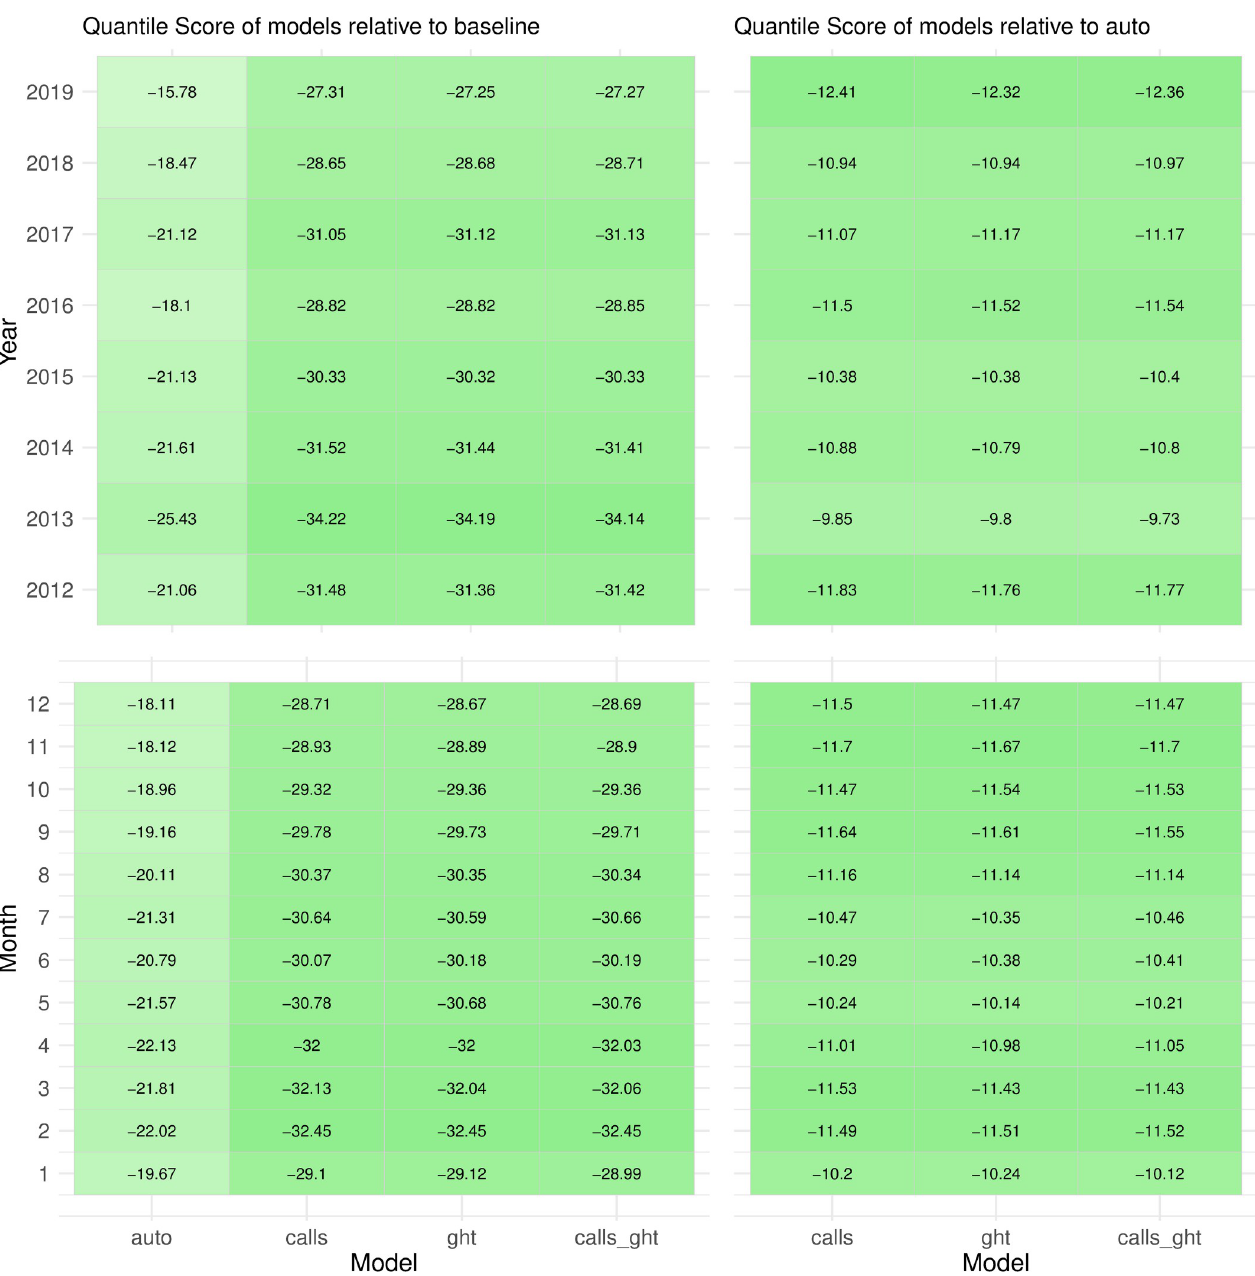
Fig 4. Quantile scores of forecasts from augmented models relative to baseline model (left column) and relative to auto model (right column), by year (top row) and month (bottom row). The relative quantile score (RQS), has a range of -100 to 100, a negative value indicating a better forecast than the reference and a positive value indicating a worse forecast. The color lightness (light to dark) represents the magnitude of difference from reference, with a darker shade implying greater